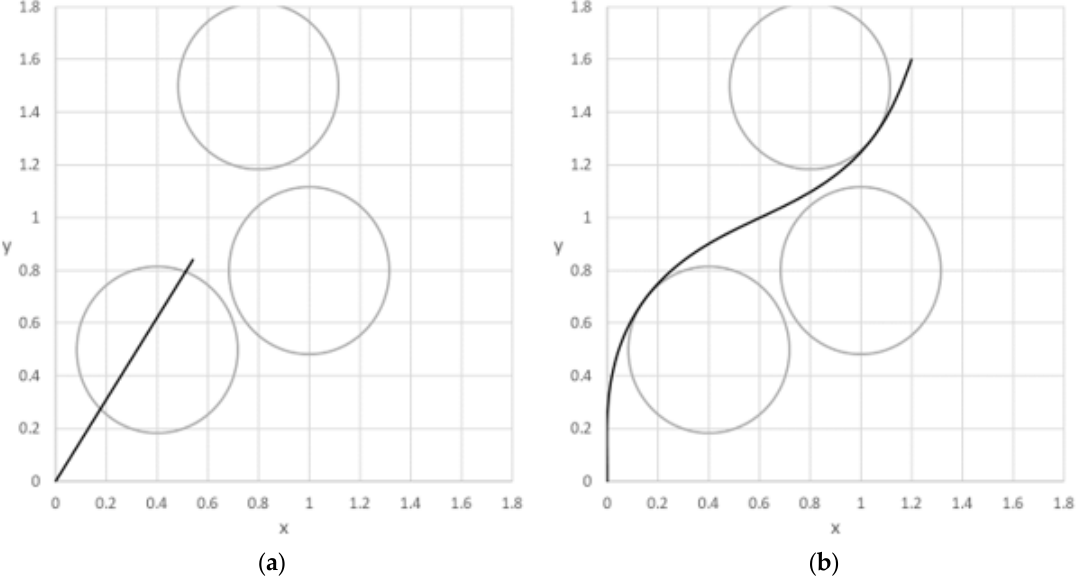
Figure 18. Initial ( a ) and optimal ( b ) trajectories for problem 3.3 with additional constraint (26).